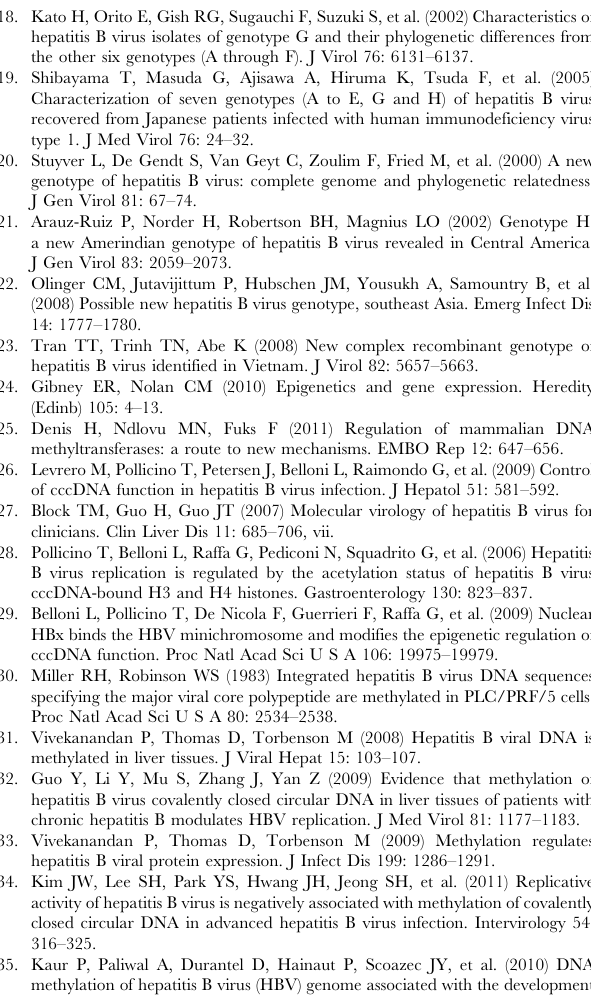
Figure S1 Number of HBV genomes with or without CpG island I within different subgenotypes.